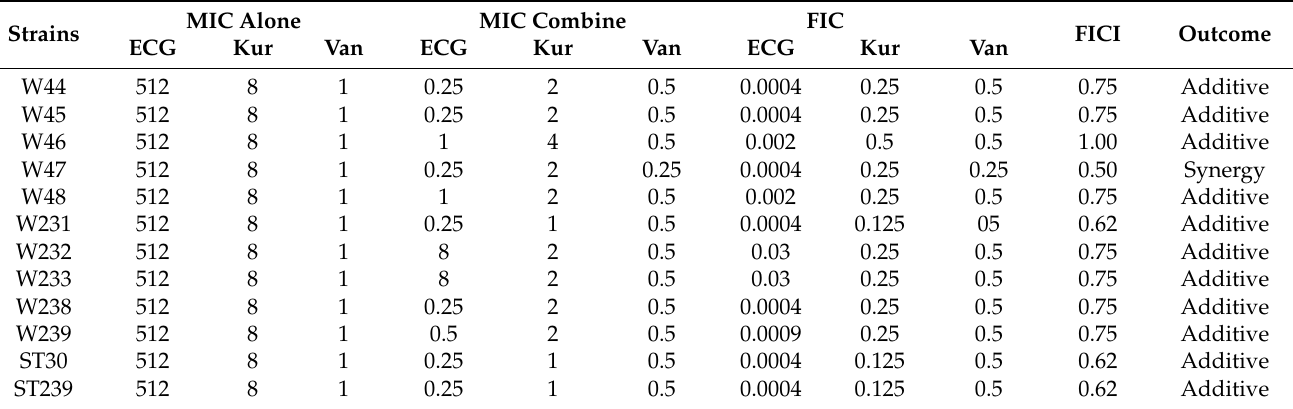
Table 5. Minimum inhibitory concentrations (MIC) ( µ g/mL) and fractional inhibitory concen- tration indices (FICI) of kuraridin and epicatechin gallate (ECG) with antibiotics against clinical MRSA